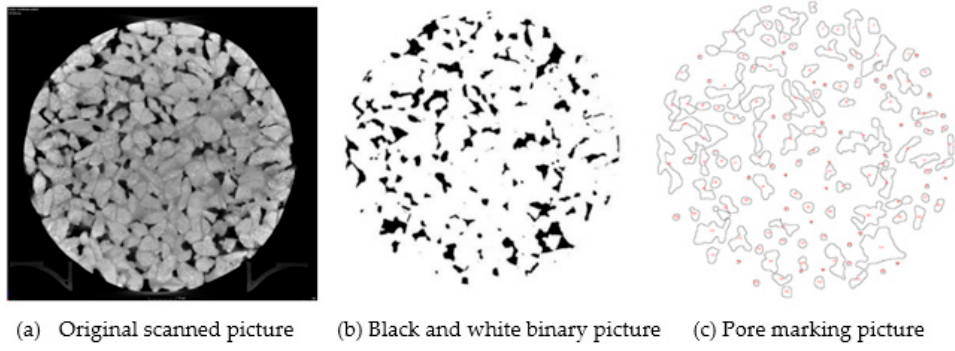
Figure 2. Pore characteristics treatment of porous concrete.